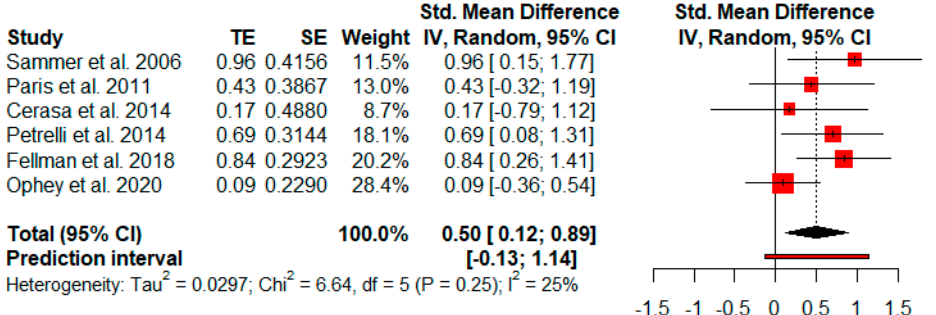
Figure 5 . Effectiveness of cognitive rehabilitation in working memory.